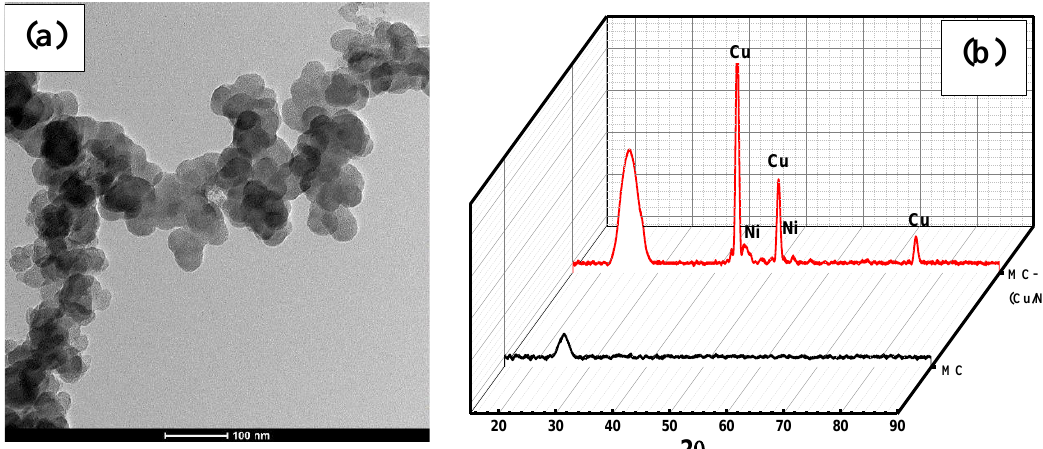
Figure 1. ( a ) TEM image of the used mesoporous carbon for catalyst synthesis and ( b ) XRD of bimetallic CuNi nanoparticle-coated mesoporous carbon.